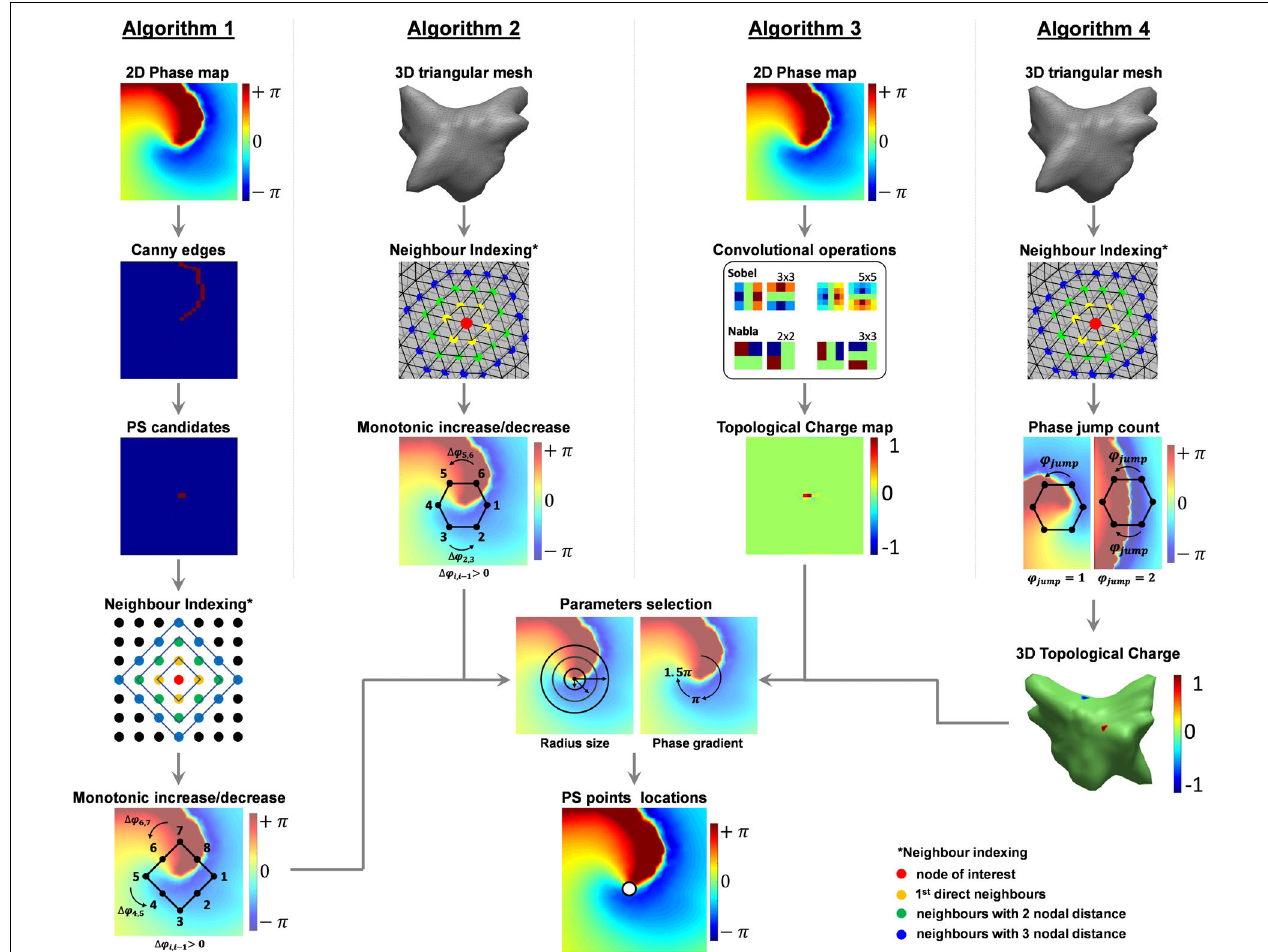
FIGURE 2 | Schematic of the three algorithms of phase singularity detection. Briefly, Algorithm 1 – Image Processing-based Algorithm: (1) Canny edge detector to locate the line with large phase gradient, (2) PS candidates pre-selected as the ends of the edge lines, (3) checking the neighbors of each candidate for monotonic change of phase, (4) applying phase gradient threshold to locate PS points; (5) Clustering PSs referring same PS using center of gravity of the cluster. Algorithm 2 – 3D Triangulation algorithm: (1) neighbors of all nodes on the 3D mesh were indexed from triangulation, (2) checking the neighbors of each node for monotonic change of phase, (3) applying phase gradient threshold to locate PS points, and (4) clustering using DBSCAN. Algorithm 3 – Topological charge: (1) calculating topologic charge using different kernels, and (2) applying topological charge threshold. Algorithm 4 – Topological charge on a 3D mesh: (1) neighbors of all nodes on the 3D mesh were indexed from triangulation, and (2) count number of “phase jumps” using topological charge, (3) assigning topological charge based on the count number.